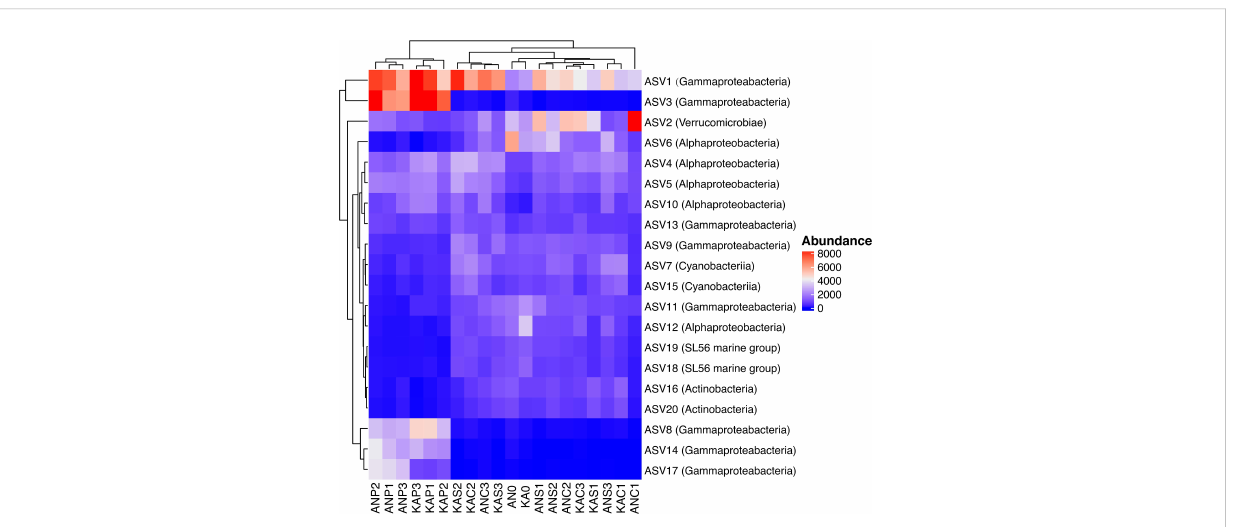
FIGURE 6 Heatmap of the 20 most abundant ASVs in different treatment, each column in the heatmap is an individual sample, each row is an ASV, with the corresponding taxonomic classi fi cation indicated at the class level in the parentheses. Clusters based on ASV abundance values. 0: day 0, C: control day 2, P: plankton extract treatment and S: soil extract treatment day 2." to "AN0 indicates the start sample in Ängerån, and ANC1, ANC2, and ANC3 indicate triplicate samples of the control taken on day 2 in Ängerån. ANP1, ANP2, and ANP3 indicate triplicate samples of the plankton extract treatment taken on day 2 in Ängerån, and ANS1, ANS2, and ANS3 indicate triplicate samples of the soil extract treatment taken on day 2 in Ängerån. KA0 indicates the start sample in Kalvarsskatan, and KAC1, KAC2, and KAC3 indicate triplicate samples of the control taken on day 2 in Kalvarsskatan. KAP1, KAP2, and KAP3 indicate triplicate samples of the plankton extract treatment taken on day 2 in Kalvarsskatan, and KAS1, KAS2, and KAS3 indicate triplicate samples of the soil extract treatment taken on day 2 in